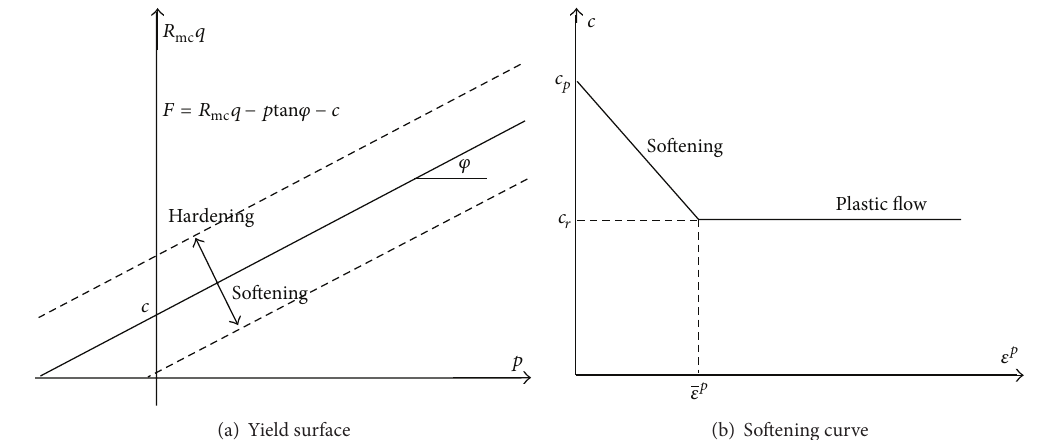
Figure 26: Constitutive model of lunar soil simulant TJ-1.